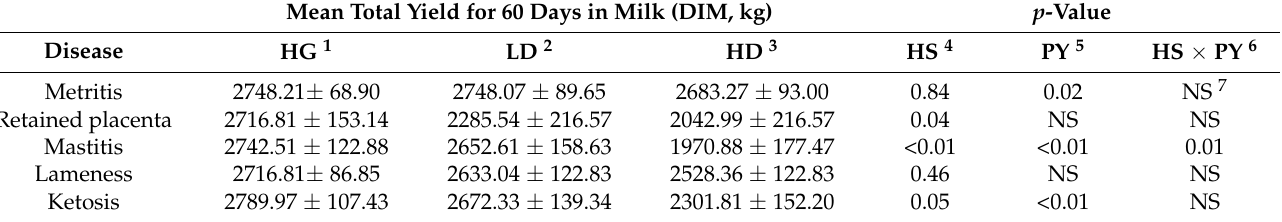
Table 6. Total milk yields comparison for 60 days in milk (DIM) among diseases and among healthy, low-disease, and high-disease